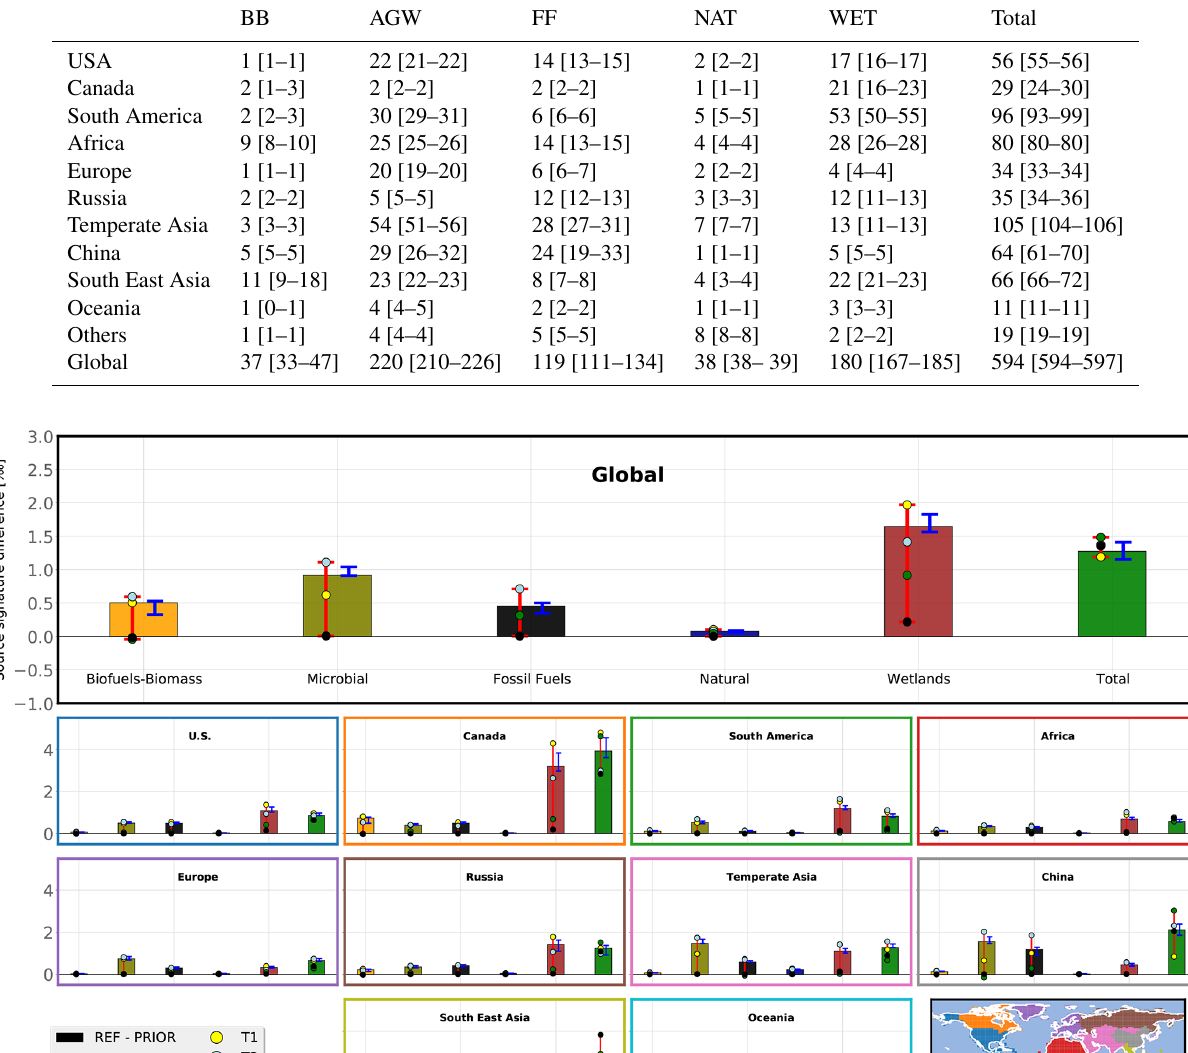
Table 3. Global posterior CH 4 emissions by source category and region (TgCH 4 yr − 1 ) for the REF configuration. Uncertainties are reported as the min–max range of all configurations in square brackets.